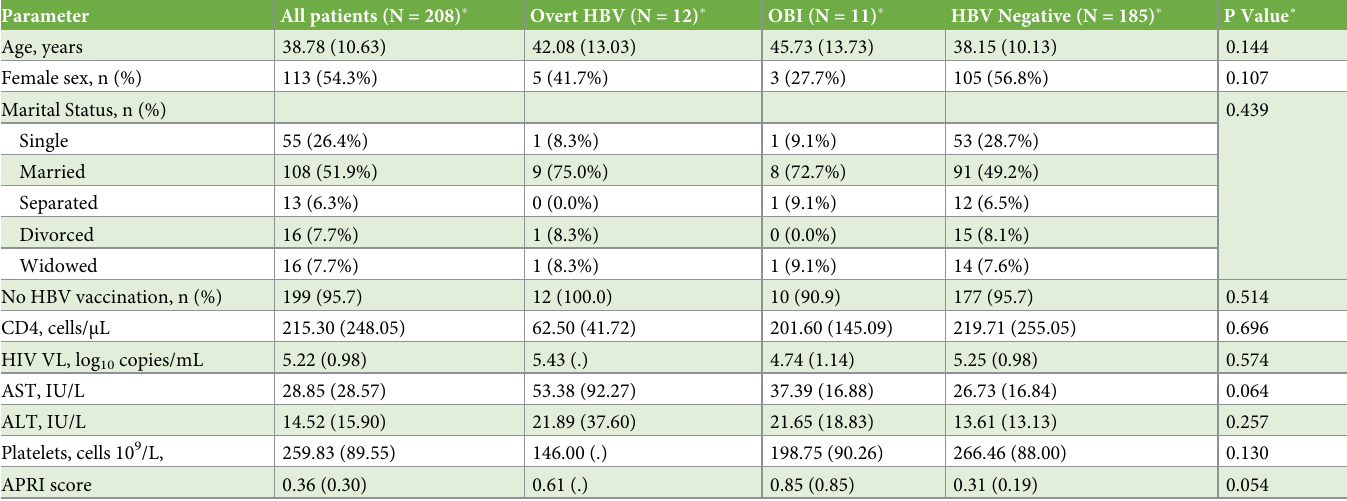
Table 1. Comparison of clinico-demographic characteristics of OBI to overt HBV and HBV negative.